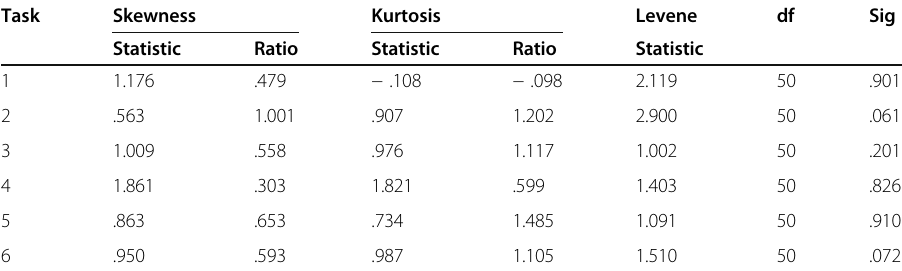
Table 6 Testing the normality assumption in feedback points on narrative writing tasks Task Skewness